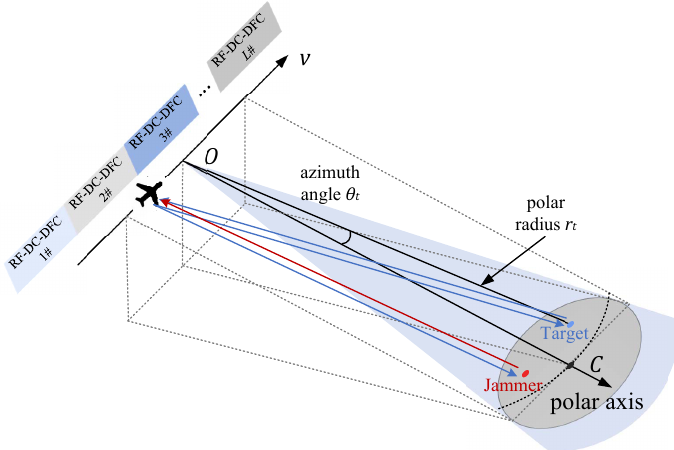
Figure 7. RSF-DC-DFC waveform application for SAR